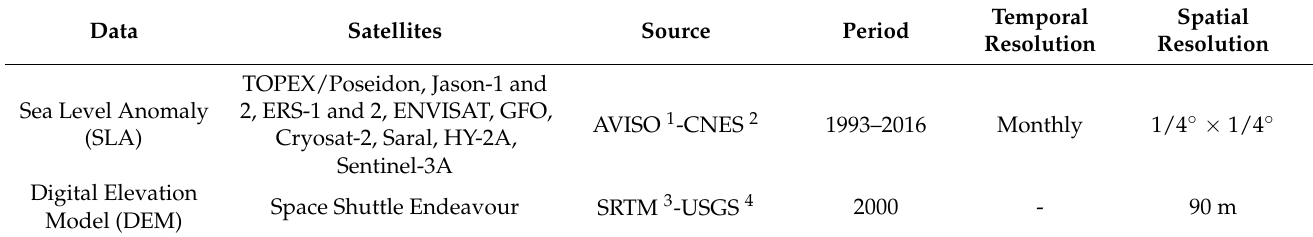
Table 3. List of principle utilized EO